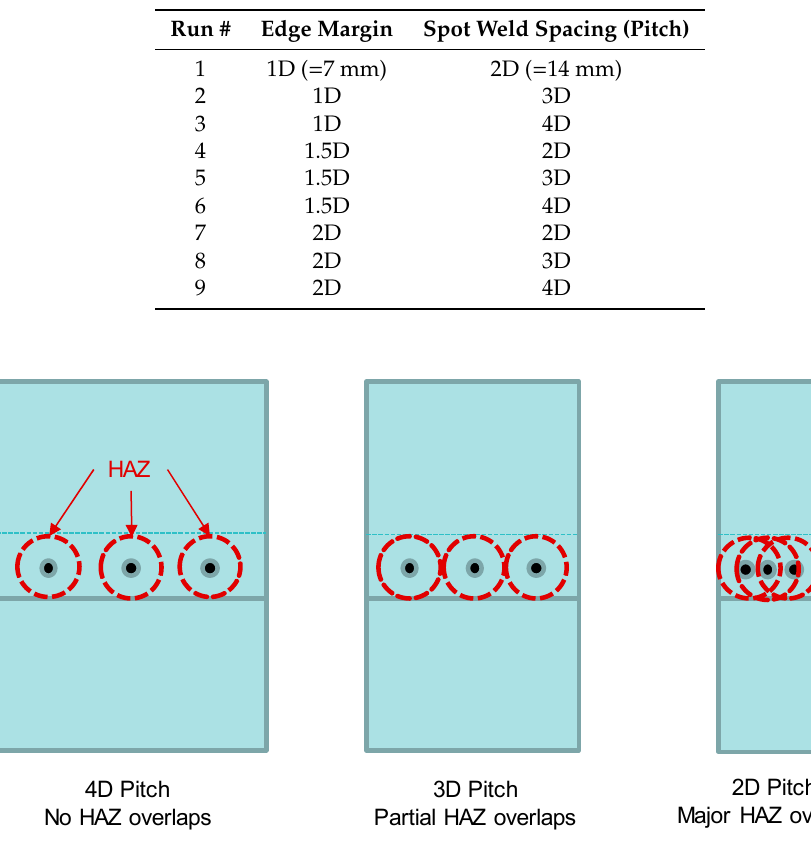
Figure 4. Heat-a ff ected zone (HAZ) and spot weld spacing (pitch). D ( = 7 mm) is the spot weld Figure 4. Heat-affected zone (HAZ) and spot weld spacing (pitch). D (=7 mm) is the spot weld diameter.